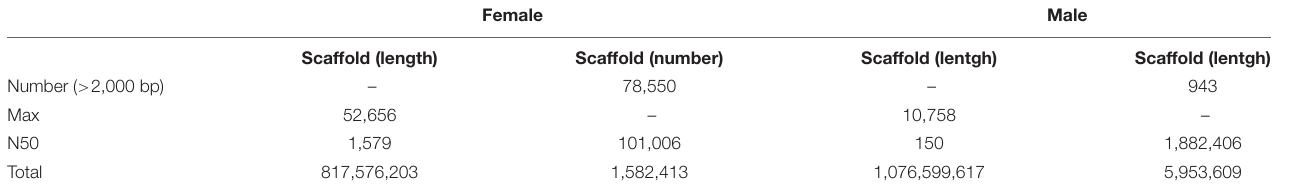
TABLE 2 | Summery of genome survey